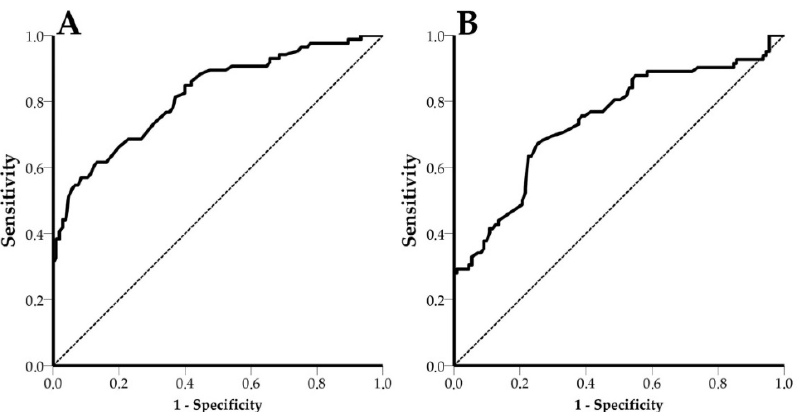
Figure 8. ROC curve for PPV and PCV-2. The dashed line represents the diagonal reference line. ( A ) PPV ROC curve, AUC = 0.820, CI: 0.760 to 0.880, p < 0.0001 and ( B ) PCV-2 ROC curve, AUC = 0.742, CI: 0.670 to 0.815, p < 0.0001.